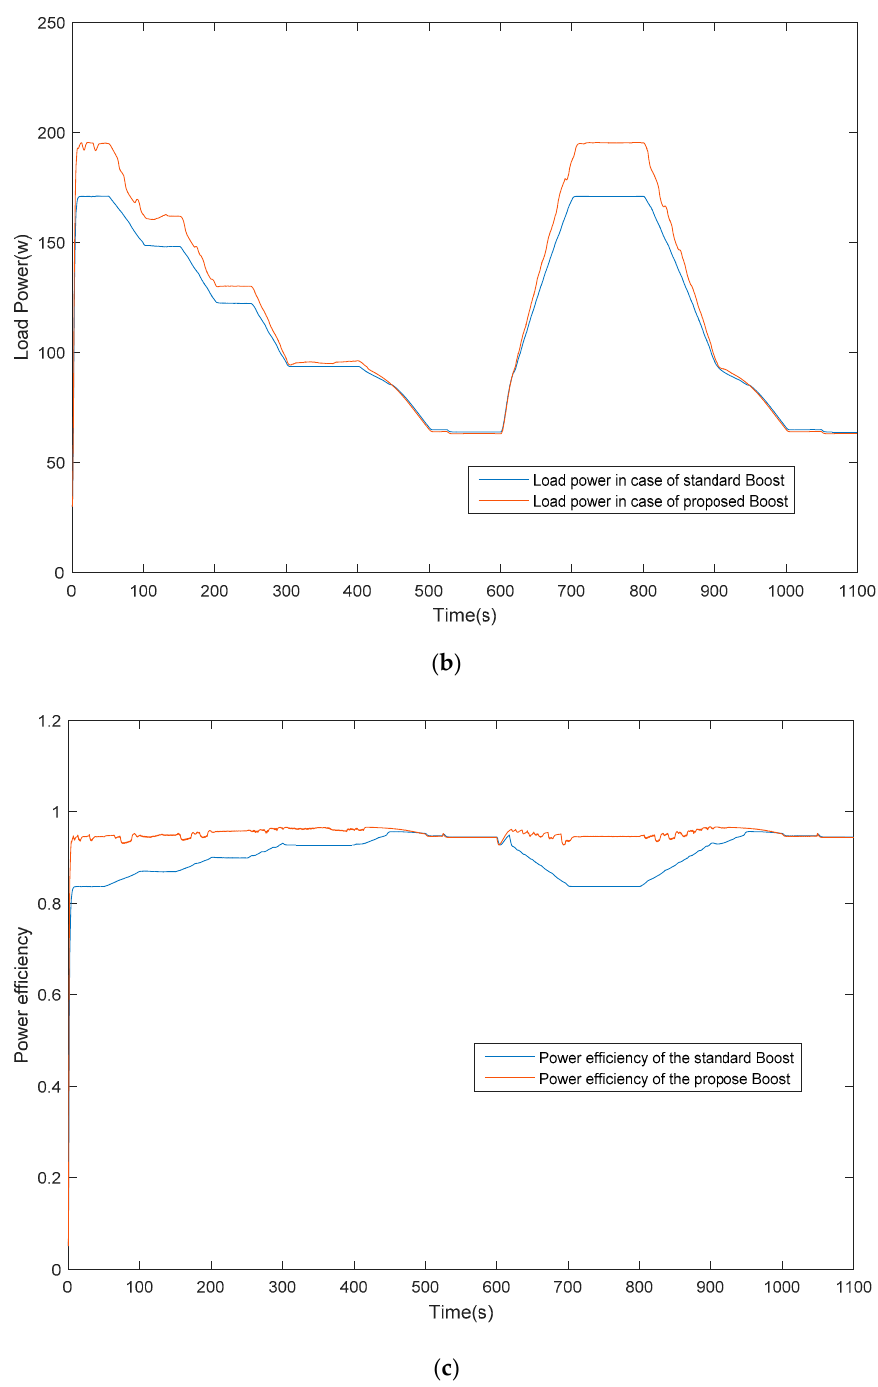
Figure 13. Transient simulation results: ( a ) solar panel radiation; ( b ) output power of the conventional and proposed converter; ( c ) power conversion efficiency.